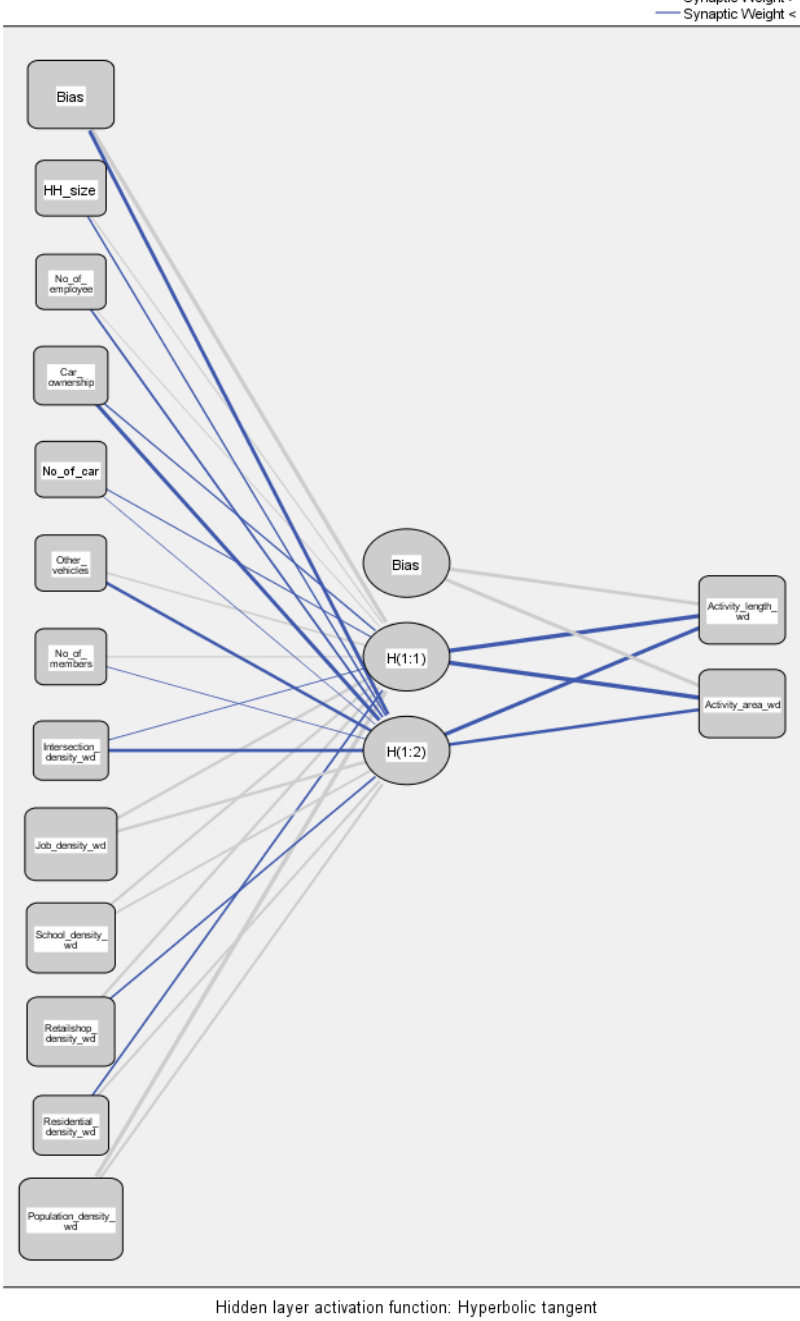
Figure 13. Network. Figure 13.